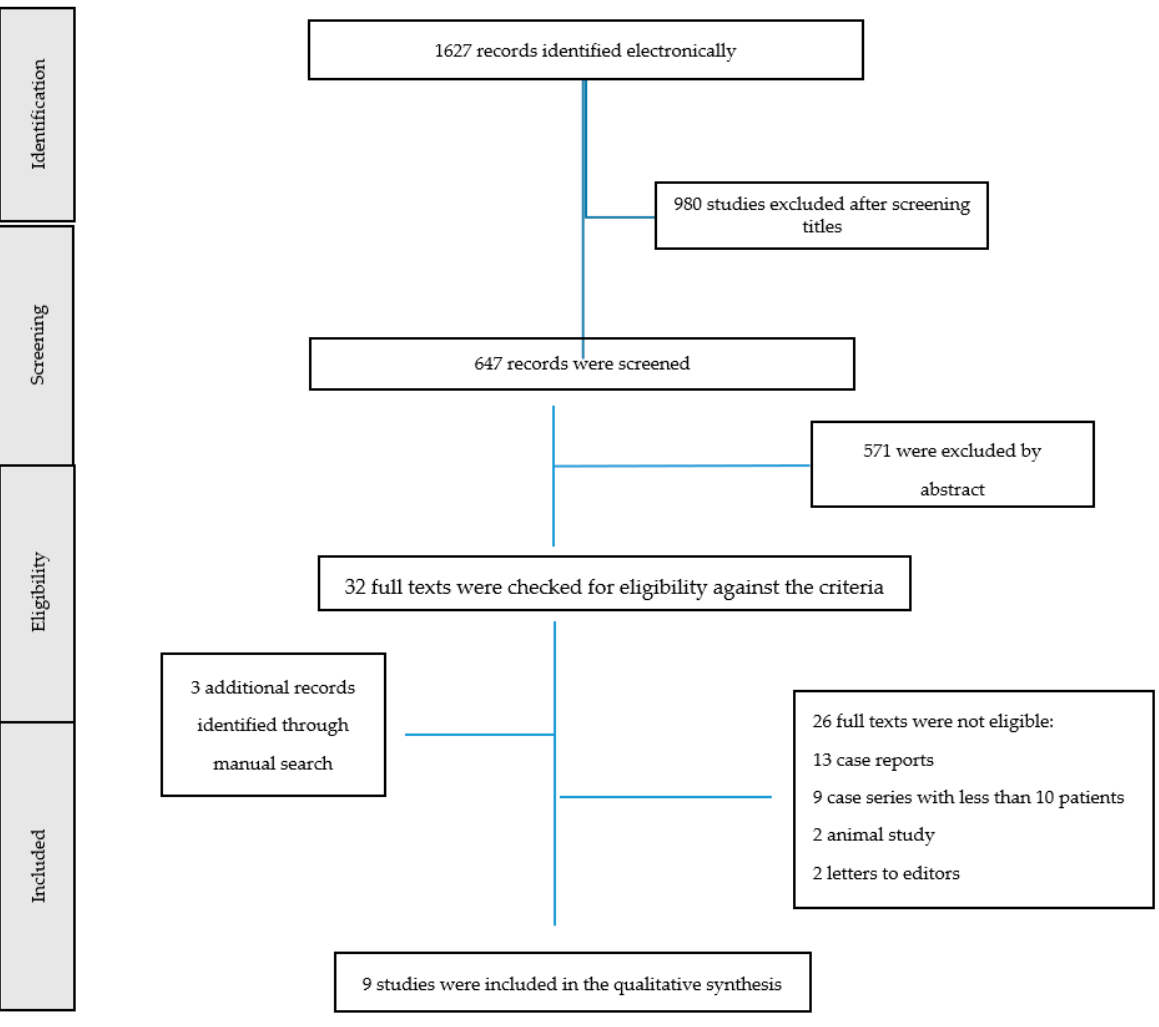
Figure 1. Flow diagram of the selection of the studies.